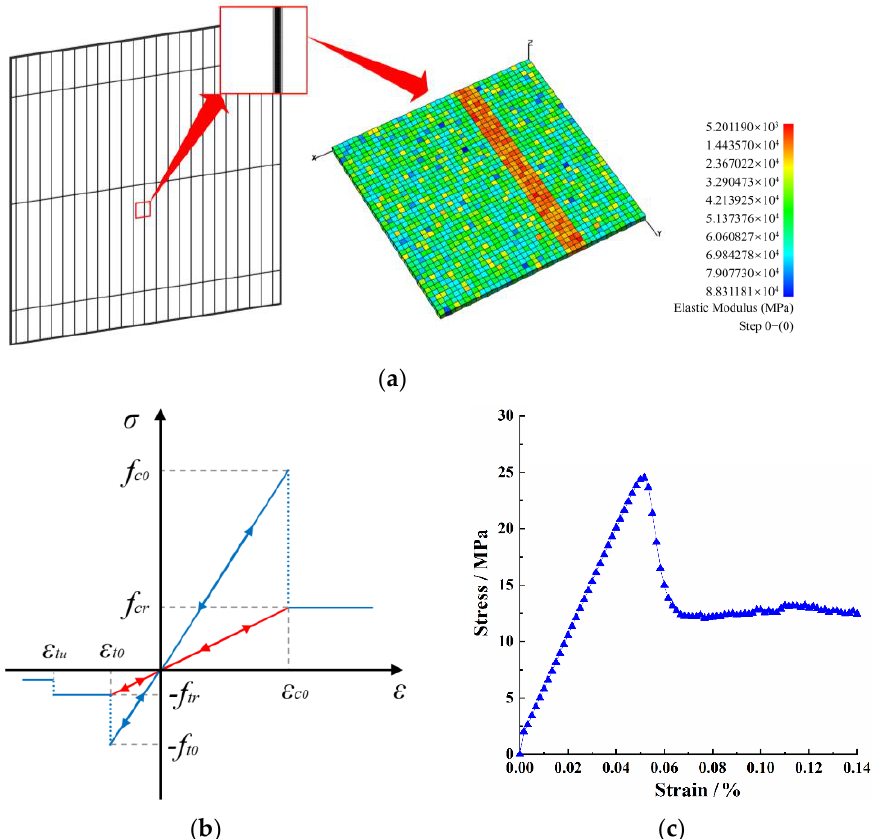
Figure 2. ( a ) The creation process of non-homogeneous numerical models; ( b ) the element constitution subject to uniaxial stress; ( c ) the stress-strain curve.